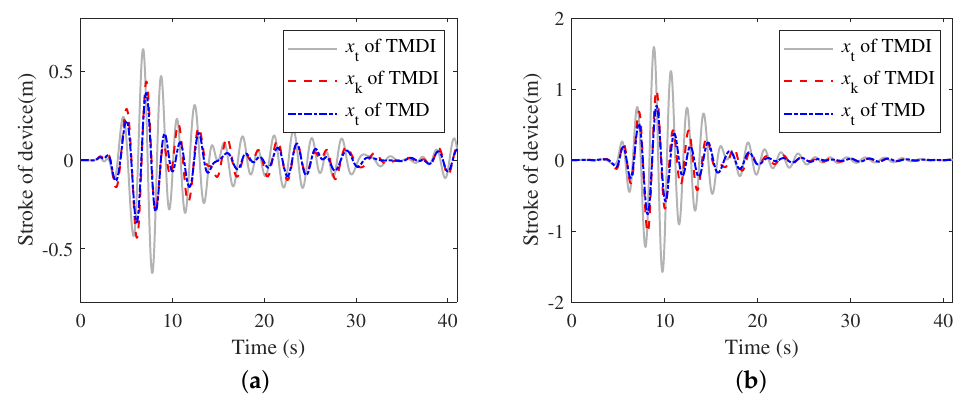
Figure 10. The stroke of different devices under earthquake: ( a ) EL Centro and ( b ) Kobe.